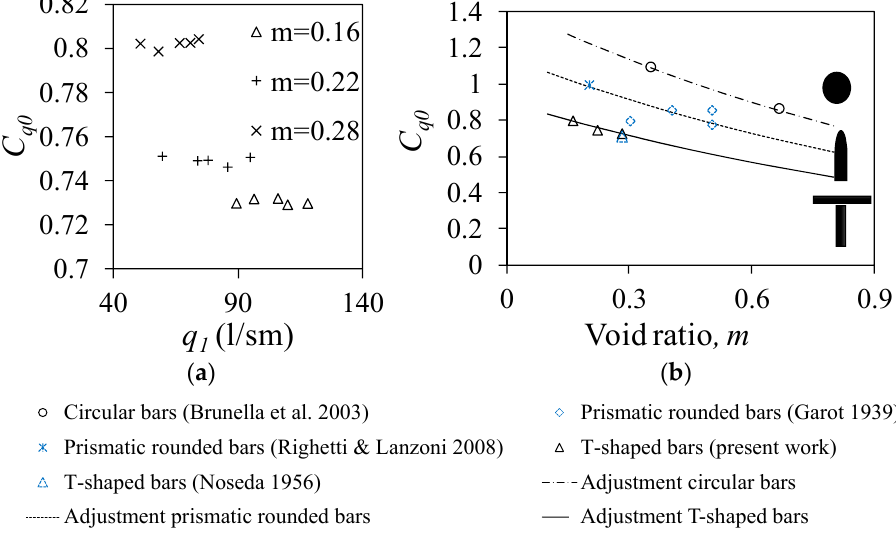
Figure 6. ( a ) Static discharge coefficient, C q 0 , for void ratios m = 0.16, 0.22, 0.28, and different approaching flows, q 1 ; ( b ) static discharge coefficient, C q 0 , from several authors with respect to the bar shape and void ratio adjusted by exponential functions.